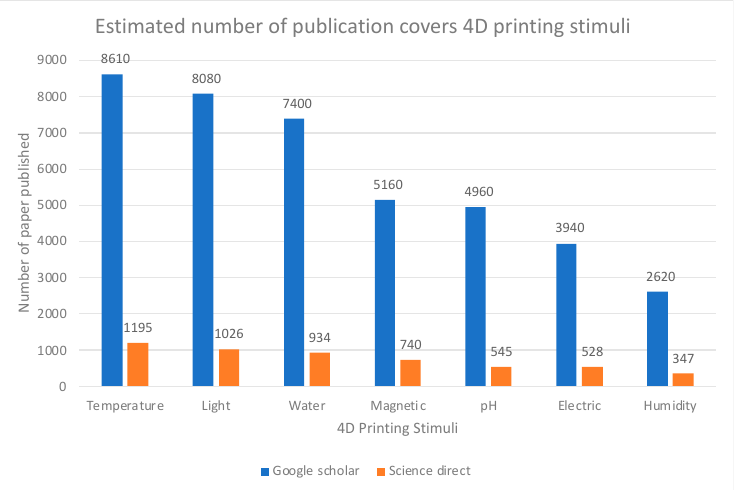
Figure 3. Number of publications about 4D printing for each stimulus between 2013 and 2022, from Google Scholar and ScienceDirect databases (as of 30 November 2022).